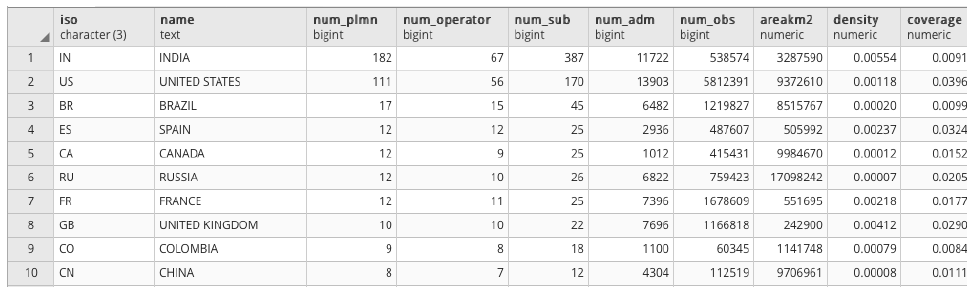
Figure 13. Top ten: PLMNs per country.